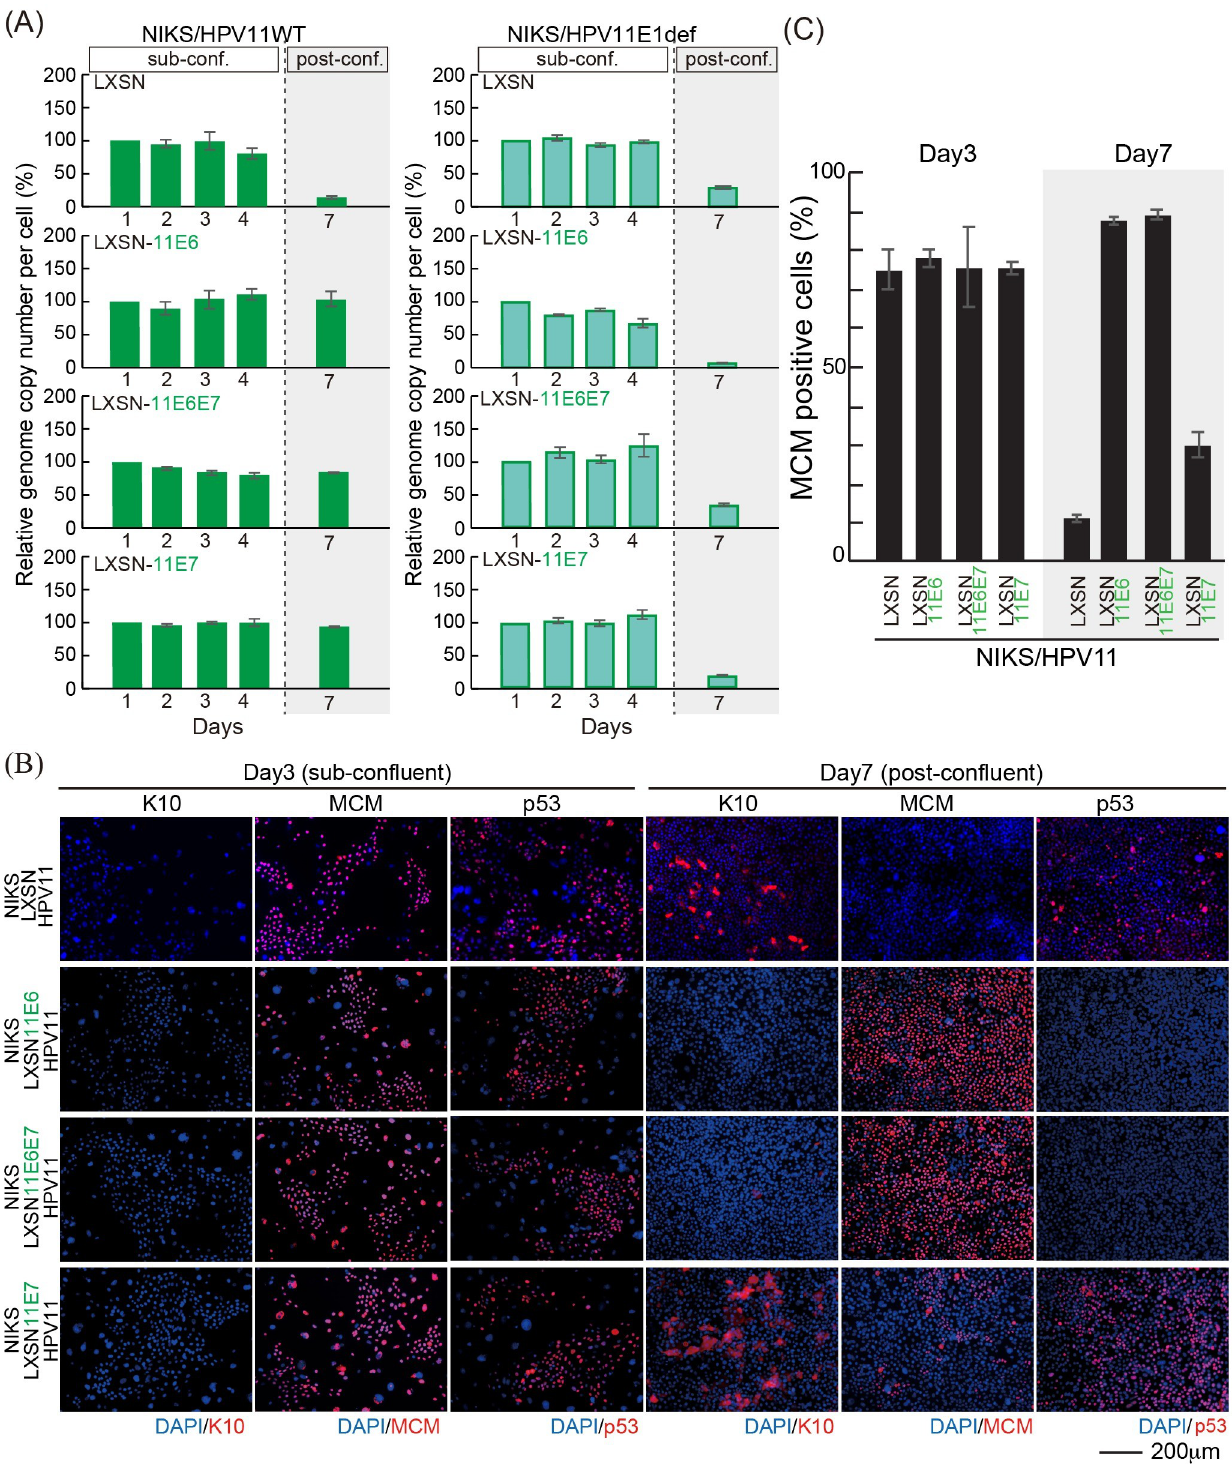
Fig 7. Low-risk HPV is maintained in NIKS expressing low-risk HPV E6 and E7 post-confluence. (A) The virus genome copy number per cell of HPV11 (left) and HPV11 E1def (right) transfected into NIKS or NIKS expressing HPV11 E6 and/or E7 was measured and prepared for presentation as outlined in Fig 1E. (B) The NIKS and NIKS expressing HPV11 E6 and/or E7 at day 3 and 7 were stained with K10 (red), MCM (red), p53 (red) and DAPI (blue). Bar = 200 μ m. The images of NIKS at day 3 and 7 were shown previously in Fig 3C. (C) The proportion of MCM positive cells shown in (B) is quantified and